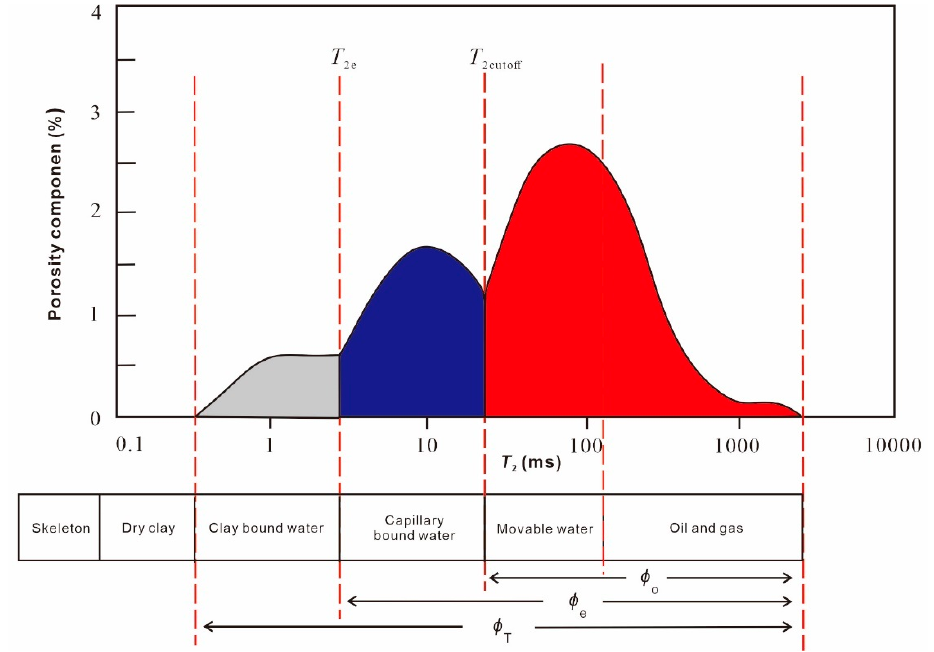
Figure 3. NMR T 2 spectrum distribution of fluid in pores and throats.